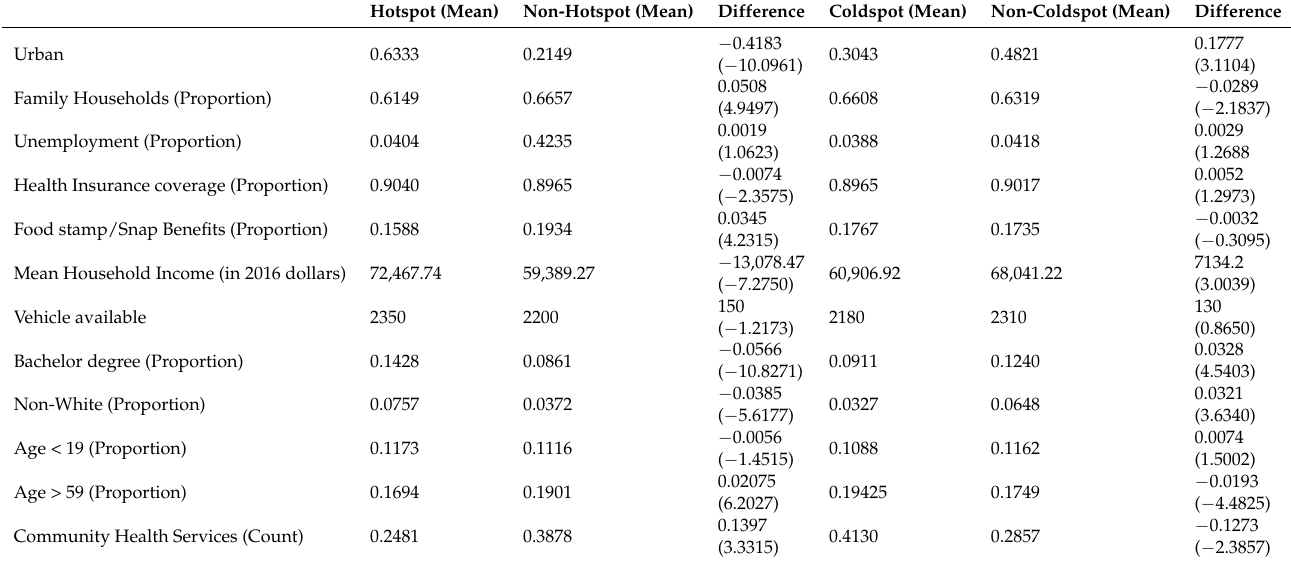
Table A1. Variable descriptive statistics for 2016 data ( t -test in parentheses).